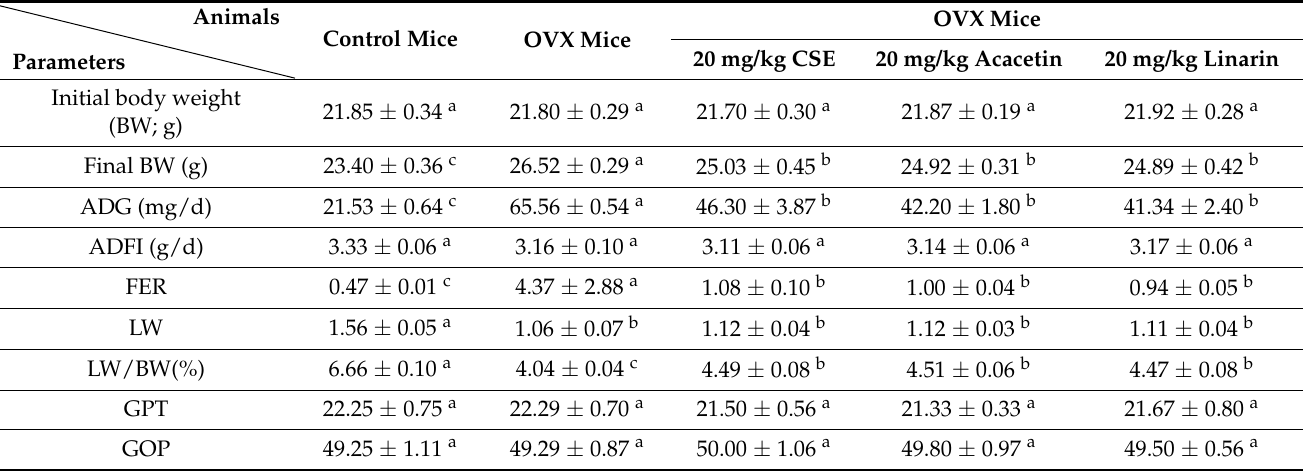
Table 2. Changes in body weight gain, feed intake, and other parameters in OVX mice induced by CSEs, acacetin, and linarin.